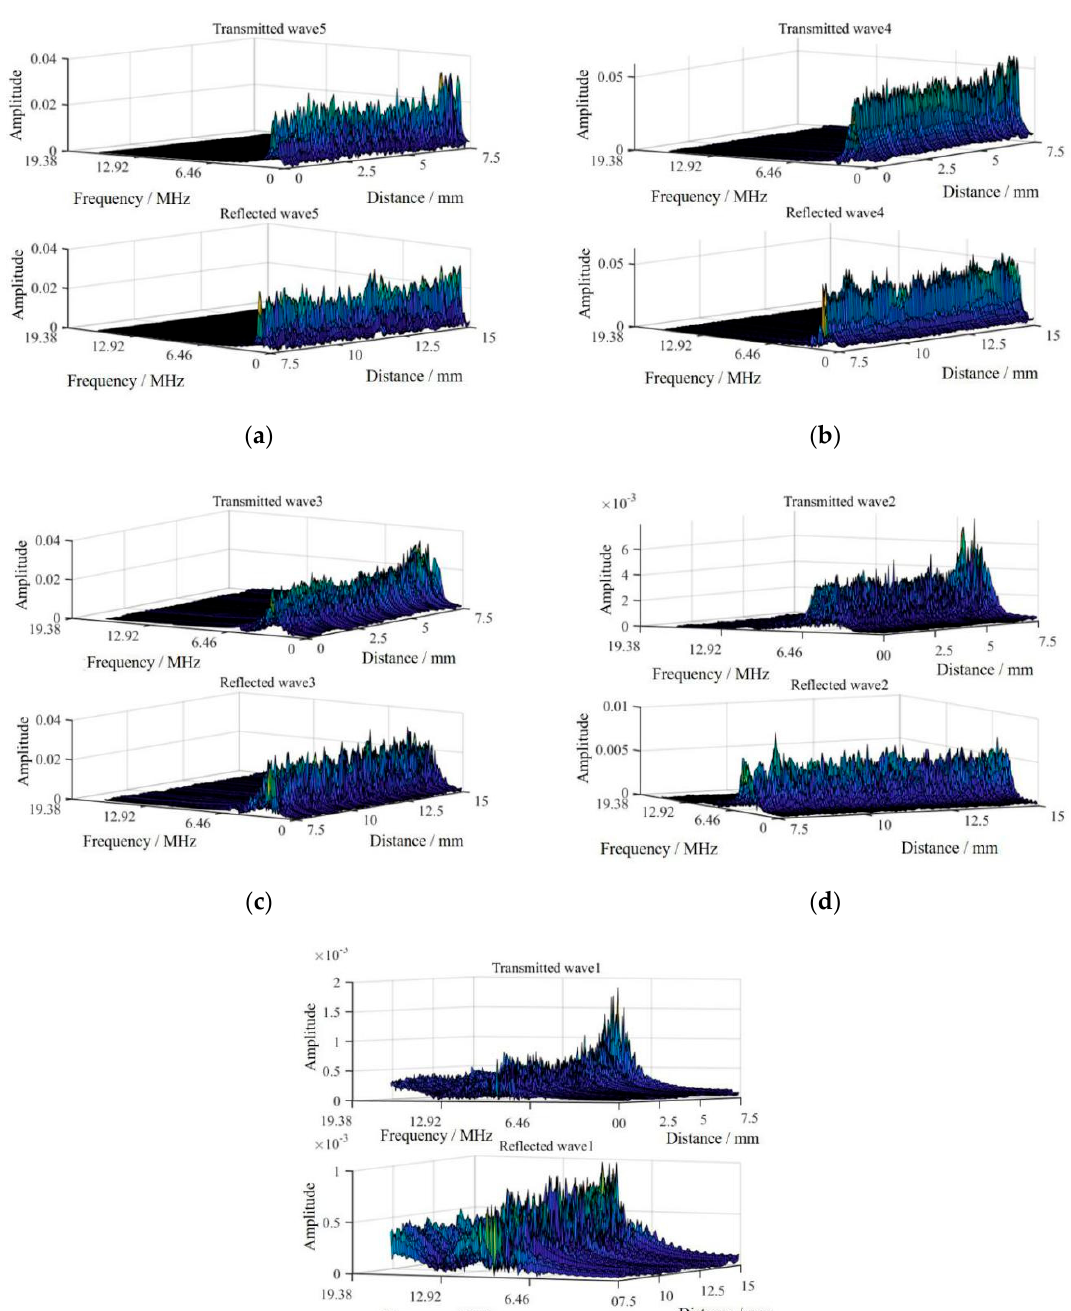
Figure 14. Decomposed signals in frequency-spatial domain. ( a ) Decomposed signals are for d1 signal, ( b ) decomposed signals are for d2 signal, ( c ) decomposed signals are for d3 signal, ( d ) decomposed signals are for d4 signal and ( e ) decomposed signals are for d5 signal.